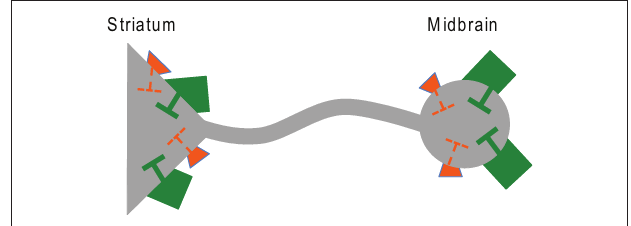
Figure 3 | illustration of dopamine D2 autoreceptors (orange) and gABA receptors (green) on somatodendritic and presynaptic sites of a B mesolimbic dopamine neuron. Maternal fmr1 insufficiency resulted in reduced D2 autoreceptor and enhanced GABA receptor function in adult B male offspring as measured by the locomotor response following quinpirole and baclofen administration, respectively.